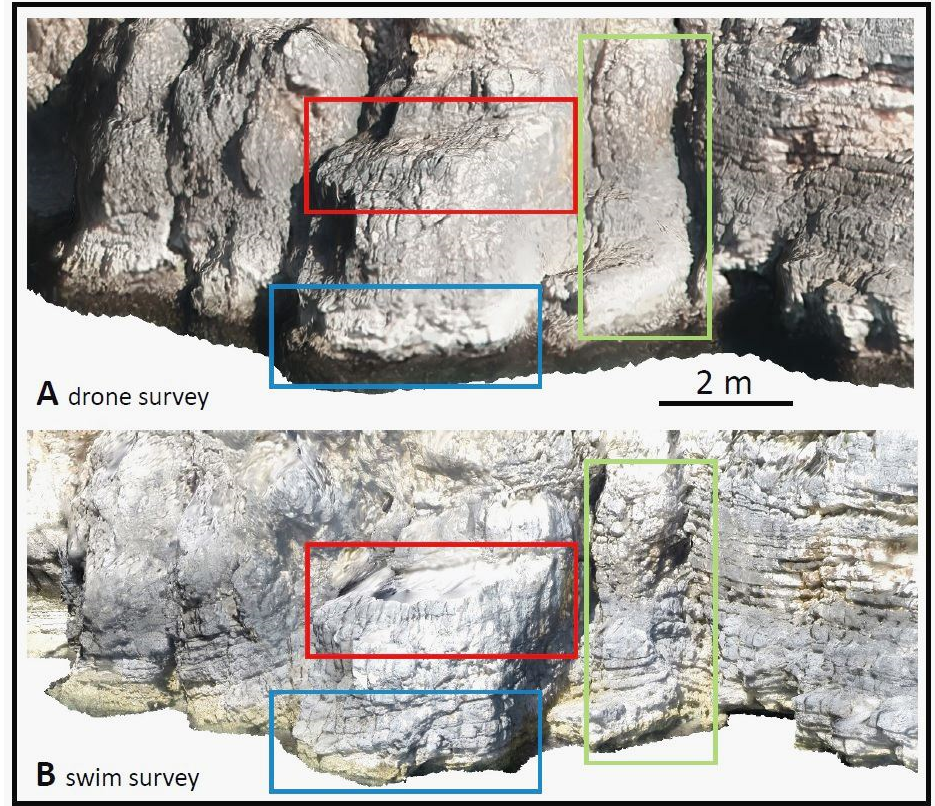
Figure 15. Comparison between a mesh model obtained using a drone survey ( A ) and a swim survey ( B ). The resolution of the sub-horizontal surfaces is higher with the drone survey, while the resolution of vertical rock surfaces in the upper tidal and nearshore zone is higher with swim survey.